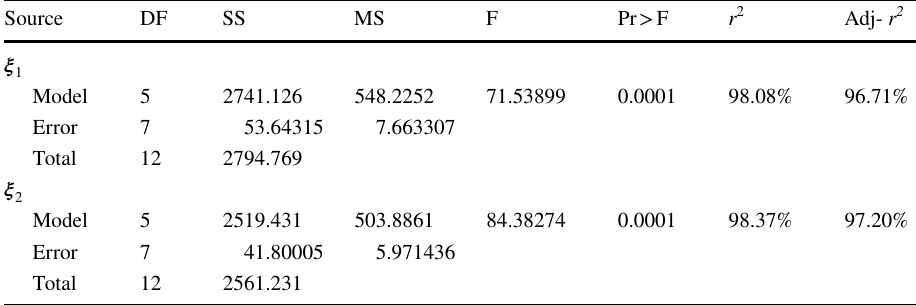
*np: nanoparticles; NA: not available; US: